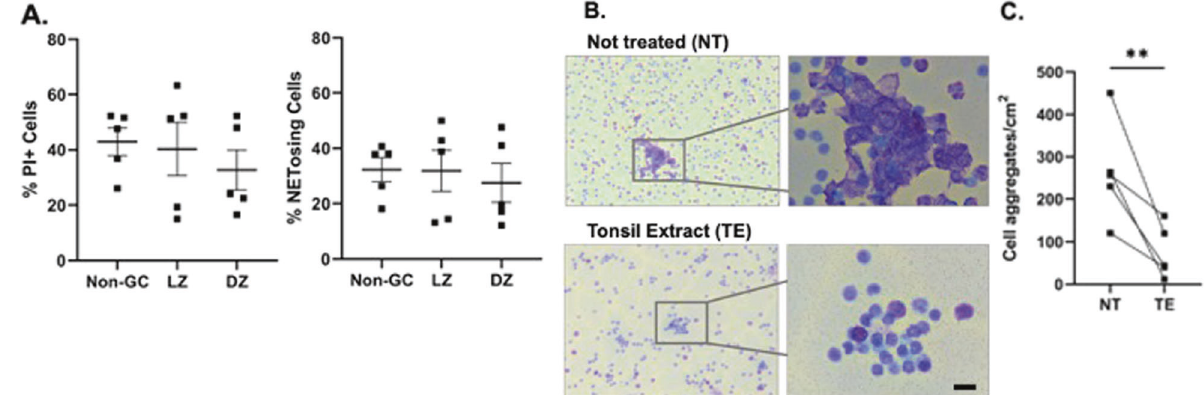
Fig. 5 Ex vivo NETosis of non-GC versus GC B cells. A Sorted Non-GC, light and dark zone B cells after 1 h culture. Percentage of total dead cells (left) and NETosing B cells (right). For statistical analysis, LZ and DZ B cells were compared to non-GC B cells; paired t -test, differences are not signi fi cant. B , C Tonsil IgM + IgD + CD27 − were isolated and cultured in FCS or tonsil extract (TE). B Representative photo of untreated (UT) (top) or cells treated with tonsil extract (TE) (bottom). C Quanti fi cation of cell aggregates/cm 2 in cells cultured in FCS or TE; Paired t -test, ** P -value < 0.01.